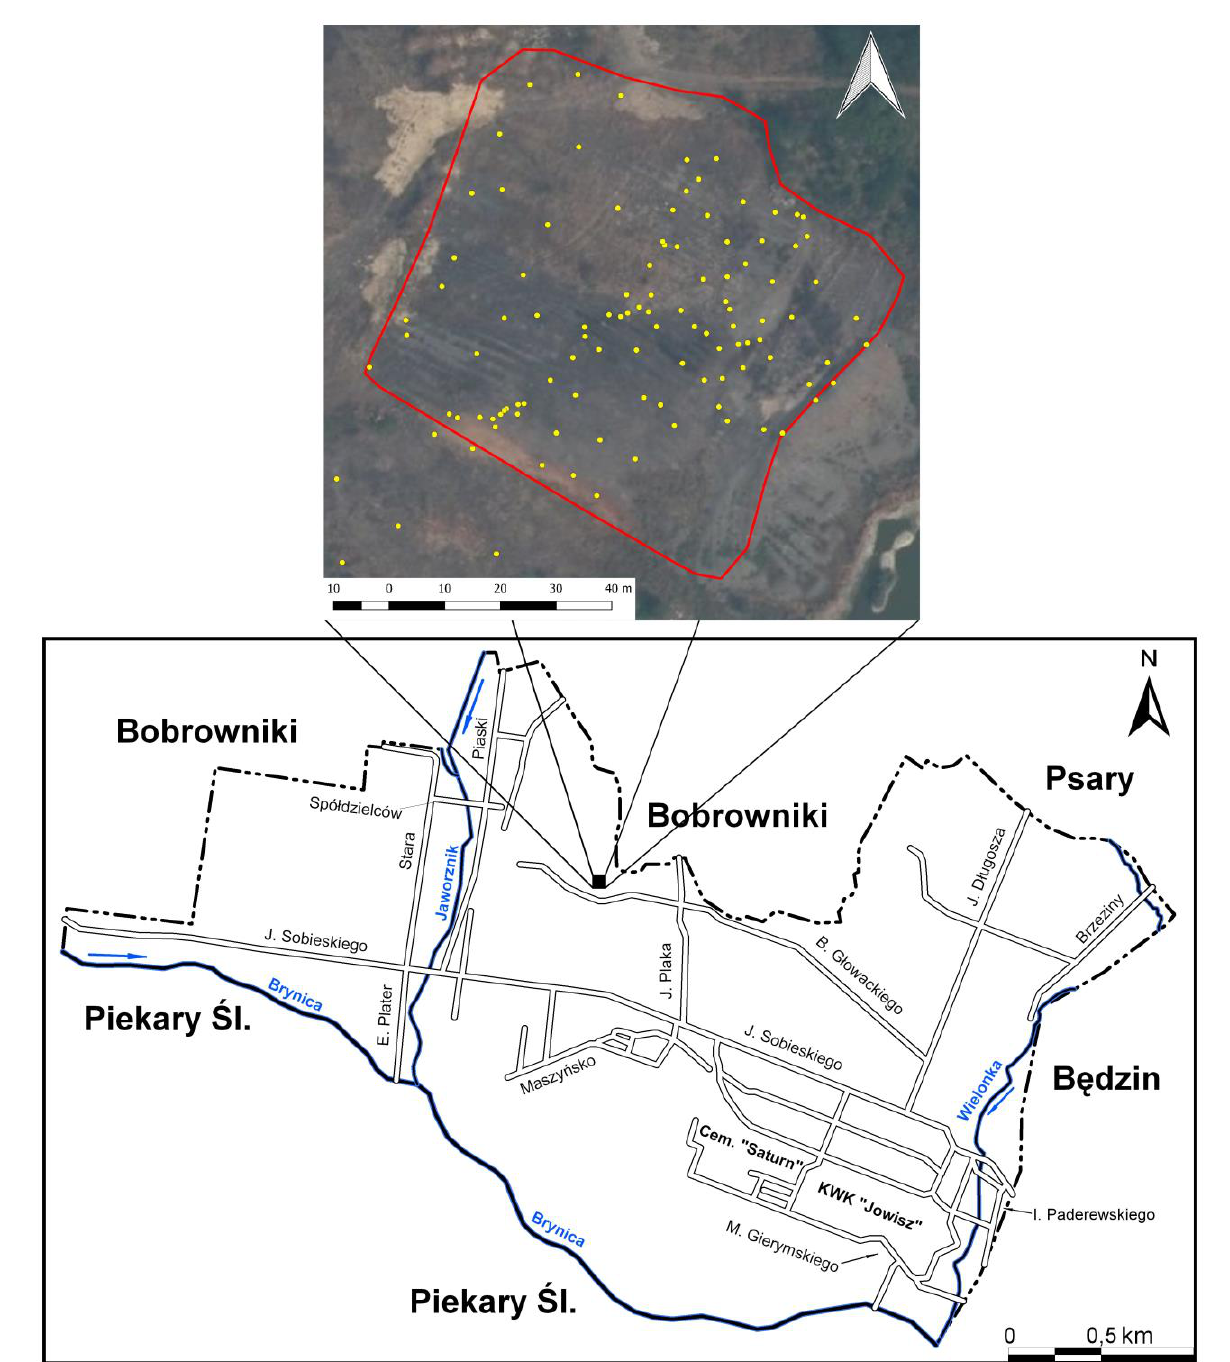
Fig. 1. Location of the "Wojkowice" spoil tip with sampling points (Zarychta R., Zarychta A. 2012, changed)